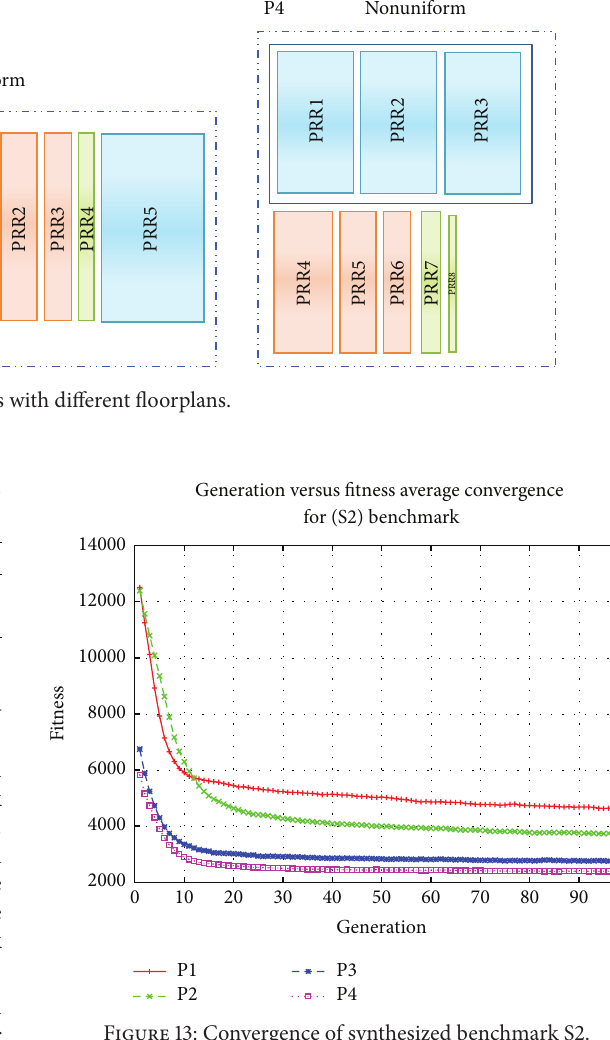
Figure 13: Convergence of synthesized benchmark S2.